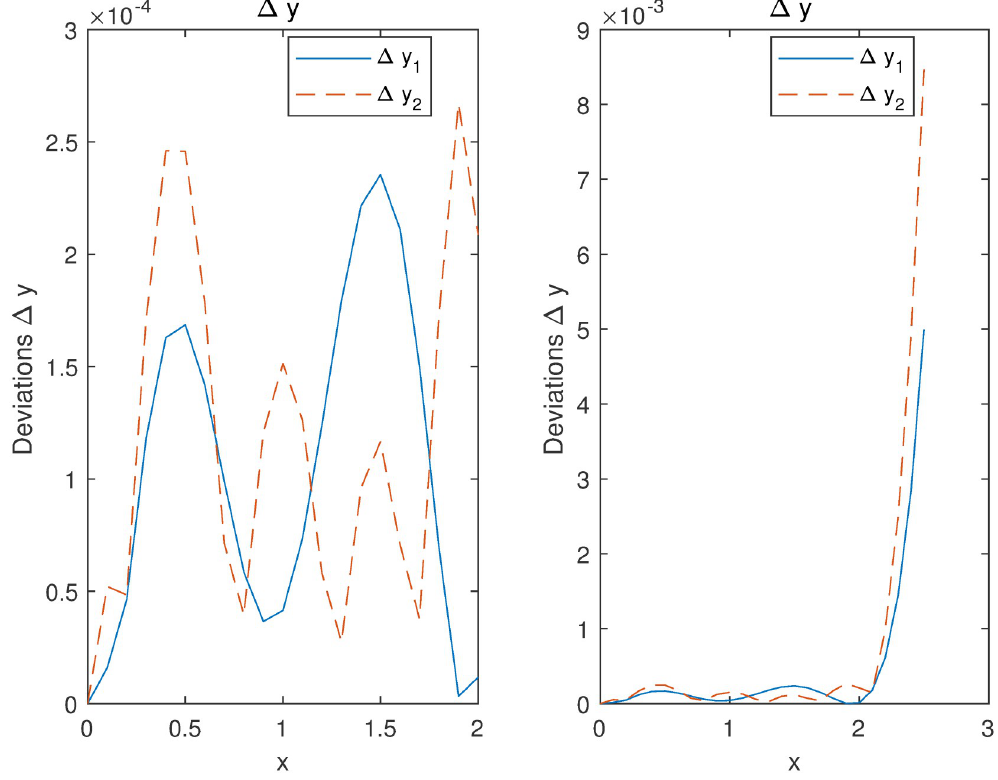
Fig 8. Accuracies of the ^ y